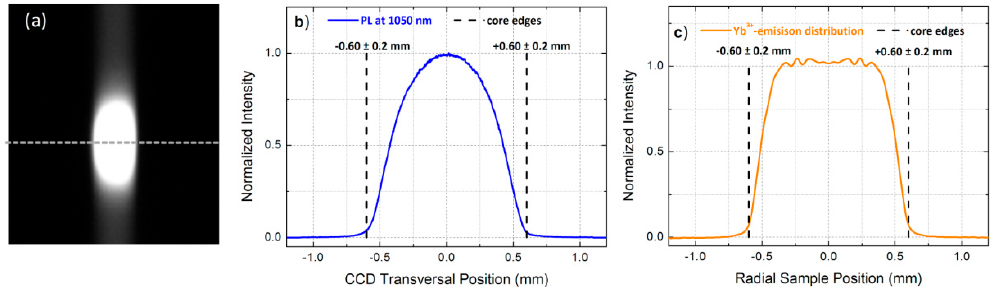
Figure 7. ( a ) CCD image of the projection of the NIR signal emitted from the preform under a double-sided laser excitation at 976 nm, ( b ) normalized PL signal profile along the central dashed line in (a), and ( c ) active-ion distribution reconstructed by the application of an inverse Abel transform of the projection curve in (b).